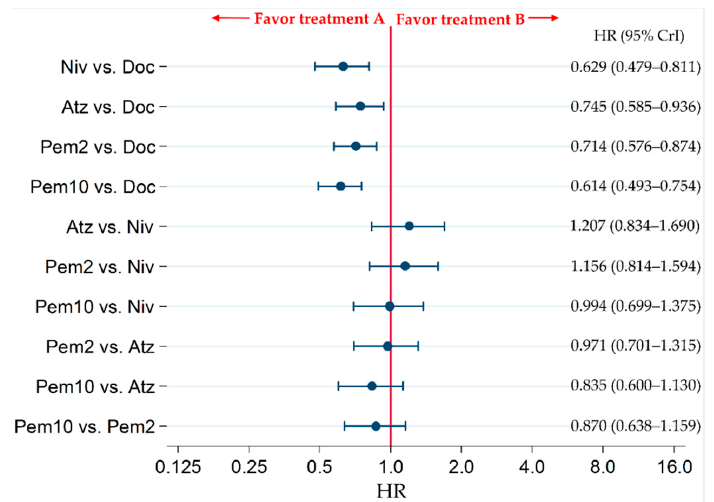
Figure 11. Comparative overall survival (OS) of patients with programmed cell death legend 1 (PD-L1) positive ( ≥ 1%) refractory or relapsed advanced non-small-cell lung cancer in the Doc, Niv, Atz, Pem2, and Pem10 groups. Comparisons are represented as treatment A versus treatment B. Data are presented as hazard ratios (HR) with 95% credible intervals (CrI); Doc (docetaxel); Niv (nivolumab); Atz (atezolizumab); Pem2 (pembrolizumab 2 mg/kg); Pem10 (pembrolizumab 10 mg/kg).